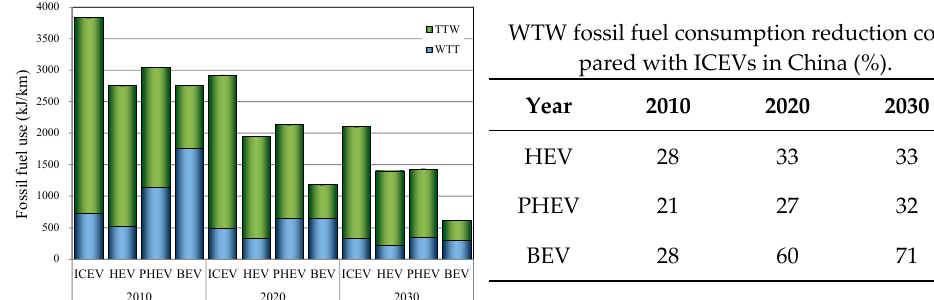
Figure 7. WTW fossil fuel consumption of ICEVs/HEVs/PHEVs/BEVs in China.